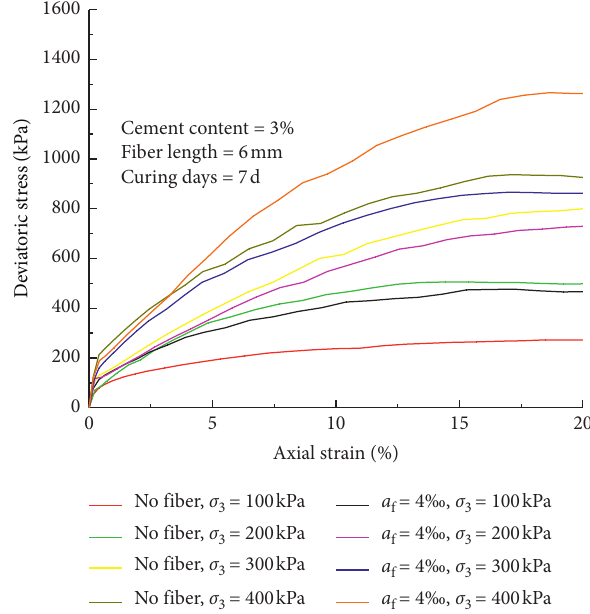
Figure 10: Effect of the confining pressure on the deviatoric stress- axial strain behavior.